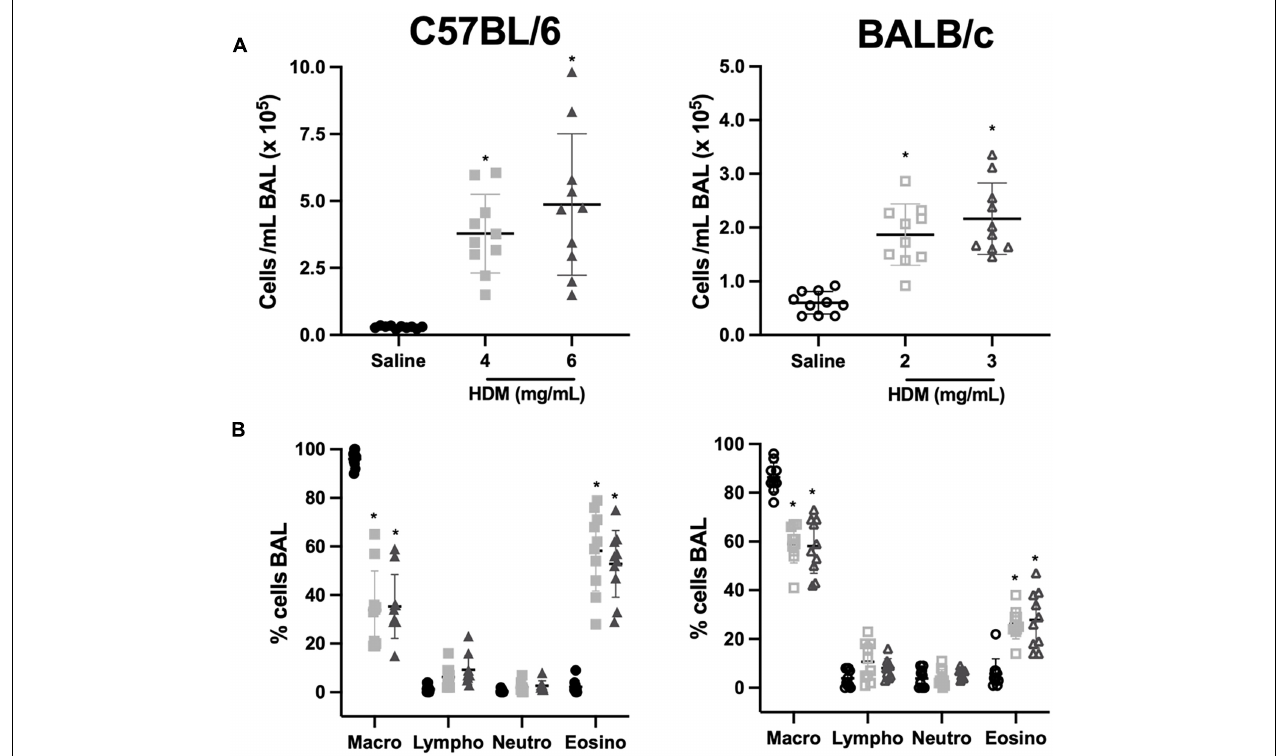
FIGURE 4 | Inflammatory cells in bronchoalveolar lavages of C57BL/6 (left panels) and BALB/c (right panels) mice exposed to either saline or one of two doses of HDM. The scatter plots in (A,B) show the number of total cells/mL and the differential cell counts in percentages, respectively. Note that the scale on the y -axes in (A) is twice greater for C57BL/6 than BALB/c mice. *Designates significantly different from saline-treated mice within the same mouse strain ( P < 0.05). Data are shown as means ± SD. n = 10 mice per group. Macro, macrophages; Lympho, lymphocytes; Neutro, neutrophils; and Eosino,